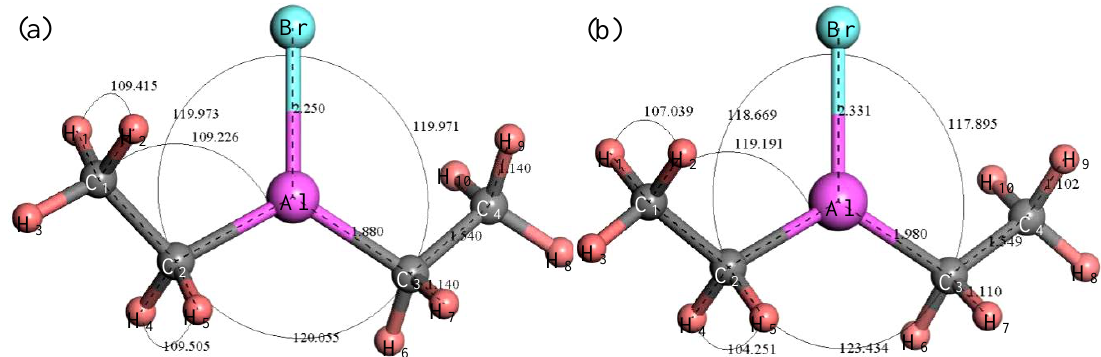
Figure 4. Molecular model of (C 2 H 5 ) 2 AlBr molecule. ( a ) Initial model; ( b ) Optimized model. The unit of the angle in the image is (°), and the unit of the bond length is angstrom (Å).